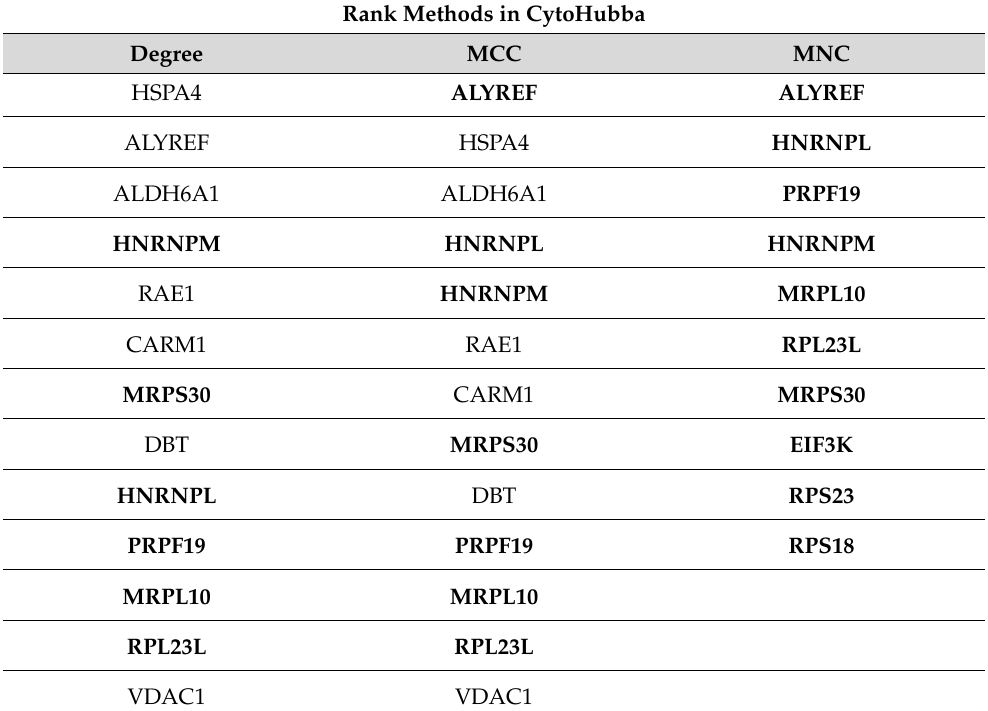
Figure 5. Protein–Protein Interaction (PPI) network analysis. The PPI network (with a String-interactions short-score ≥ 2) included 53 nodes and 44 edges. Orange nodes represent overlapping proteins between three topological analyses. Table 4. Hub proteins ranked with a score ≥ 2 in the cytoHubba plugin of Cytoscape with the three topological analyses: Degree, maximal clique centrality (MCC) and maximum neighborhood component (MNC). The 10 proteins common to the three algorithms are presented in